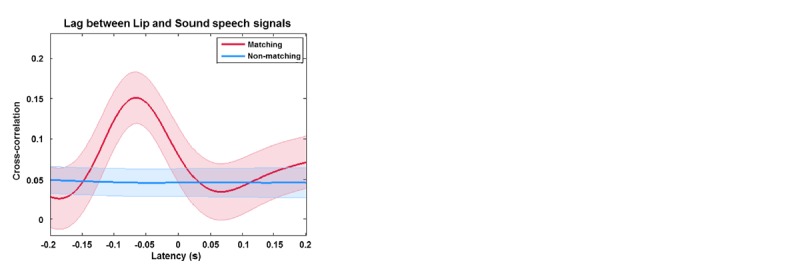
DOI:
http://dx.doi.org/10.7554/eLife.14521.015